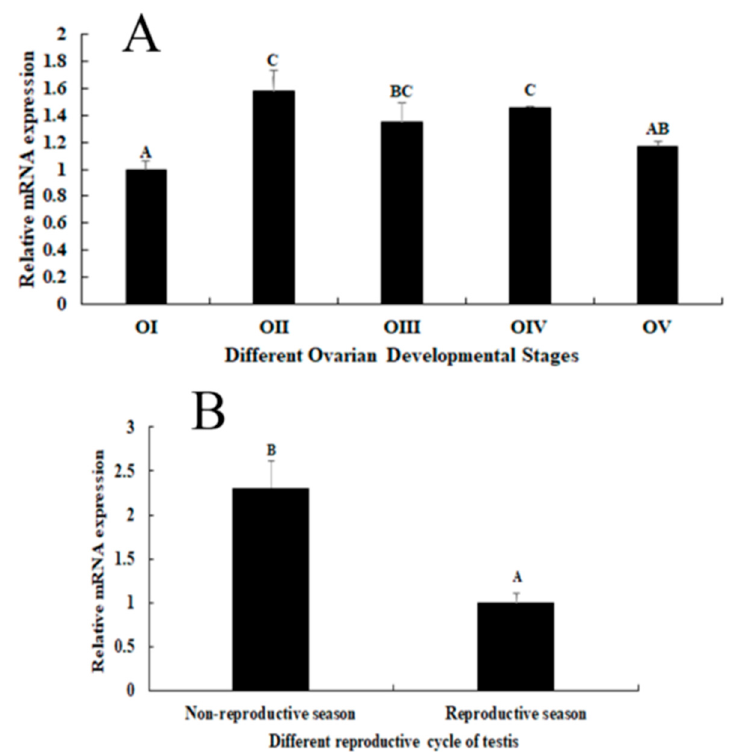
Figure 4. Expression characterization of Mn-GEM in different reproductive cycles of testis and ovary . The amount of Mn-GEM mRNA was normalized to the EIF transcript level. Data are shown as mean + SD (standard deviation) of tissues from three separate individuals. Capital letters indicate expression difference between different samples. ( A ) Expression characterization in different reproductive cycles of ovary. ( B ) Expression characterization in different reproductive season of testis.